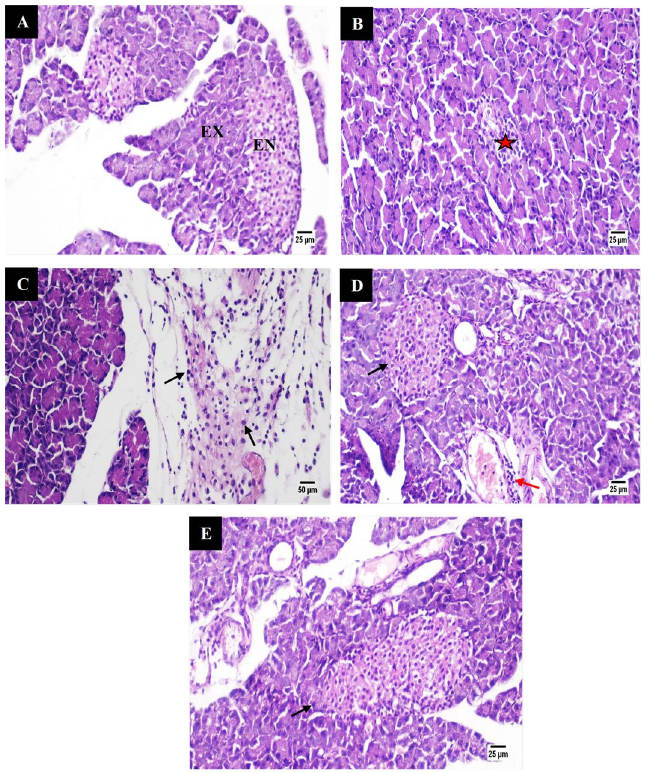
Figure 15. Photomicrographs of H&E-stained sections of pancreas. ( A ) Control rats showing the endocrine pancreas (EN) with histologic features of normal islets. The exocrine pancreatic acini (EX) appear with normal pyramidal lining cells, showing basal basophilia and apical acidophilia. ( B , C ) The diabetic group showing small ill-distinct islets containing vacuolated and necrotic cells (red star) and inflammatory cell infiltration (arrows). ( D ) MTF-treated group showing an apparent improvement in area occupied by the islet (black arrow) with mild perivascular mononuclear inflammatory cells infiltration (red arrow). ( E ) MTF-loaded LCS-ALG bead-treated group showing apparently normal islets of Langerhans (arrow).